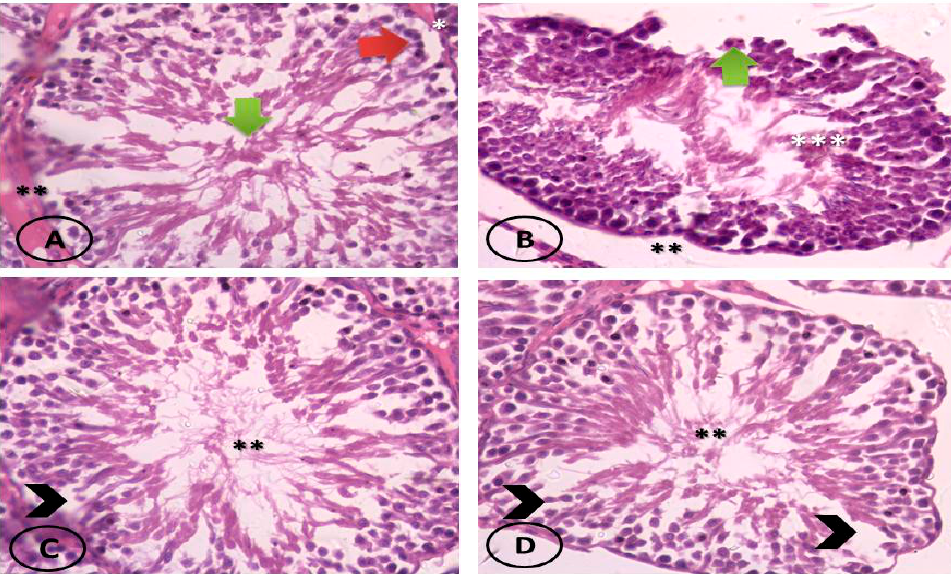
Figure 6. Photomicrograph of cross-section of ( A ) control group showing normal histological struc- ture of seminiferous tubule and interstitial tissue (**). The seminiferous tubules consists of normal somatic sperms (green arrow), and spermatogenic cells (red arrow), surrounded by peritubular myoid cells (*). (H&E × 400). ( B ) Photomicrograph of cross-section of experimental mice after ad- ministration of toxic material. The seminiferous tubules contain some normal somatic sperms and showing toxicity in the form of degenerative changes of germ cells (***), expansion of